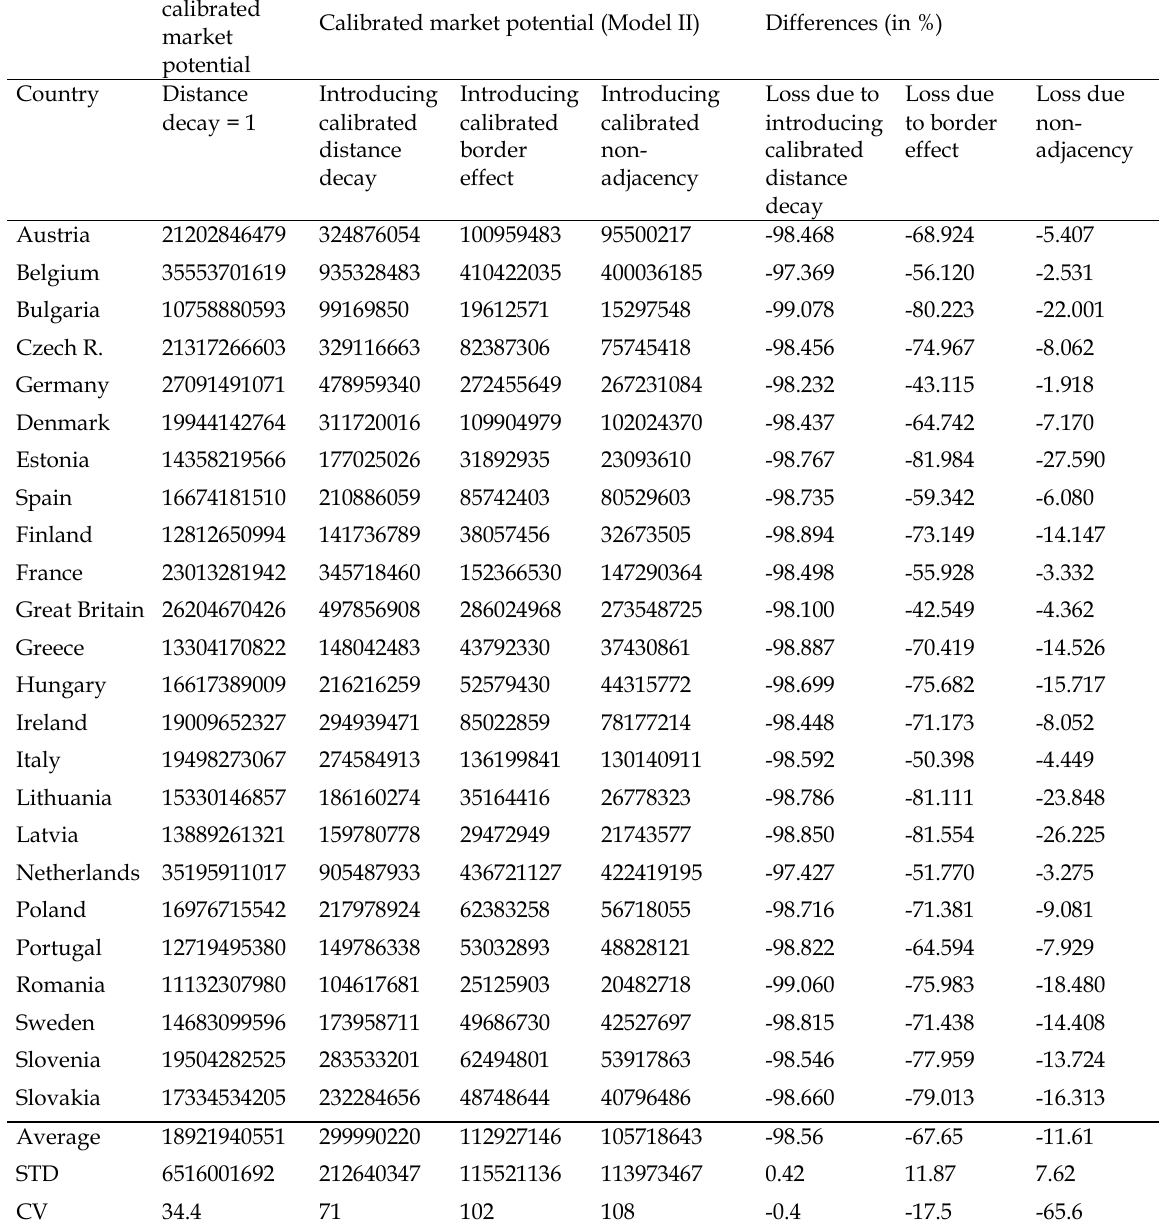
Table 3. Market potential values: effects of the introduction of the different parameters of model II (results per